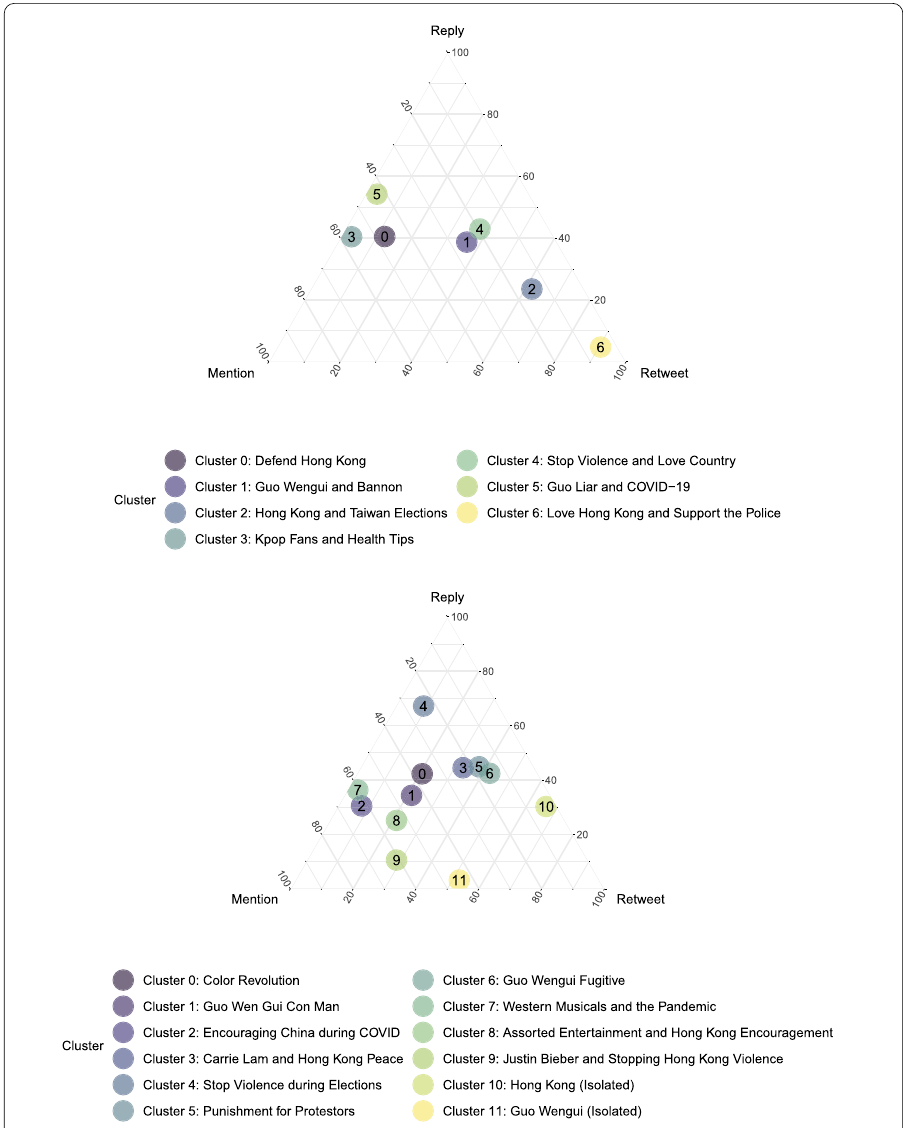
Figure 8 Relative interaction preferences for account clusters normalized to values between 0 and 1. Most clusters specialize in mentions and replies, with a few outliers specializing in retweets. Top: Results for Era 1. Bottom: Results for Era